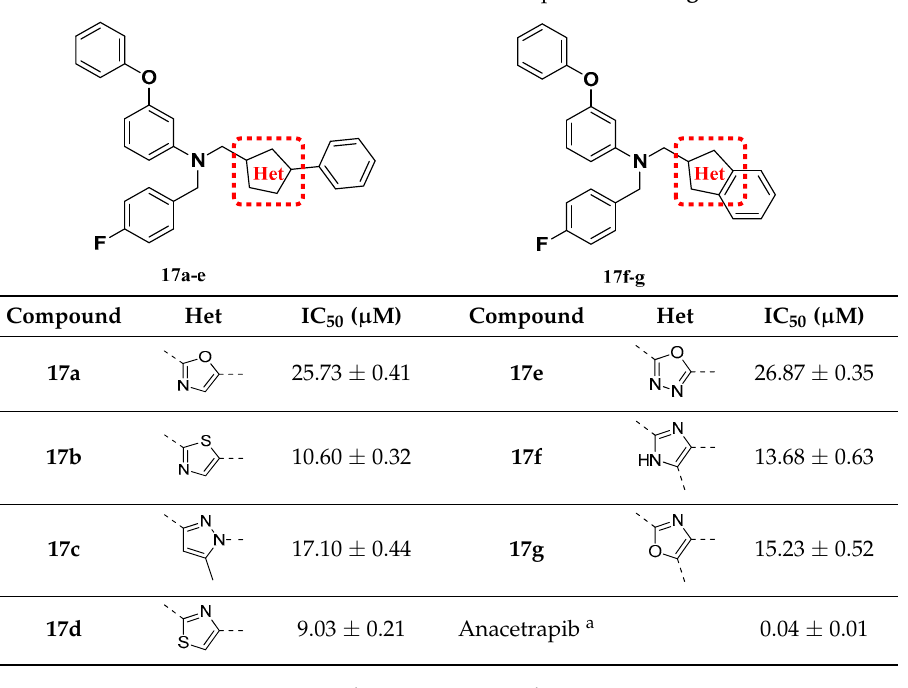
Table 2. Structures and activities of compounds 21 to 49 .